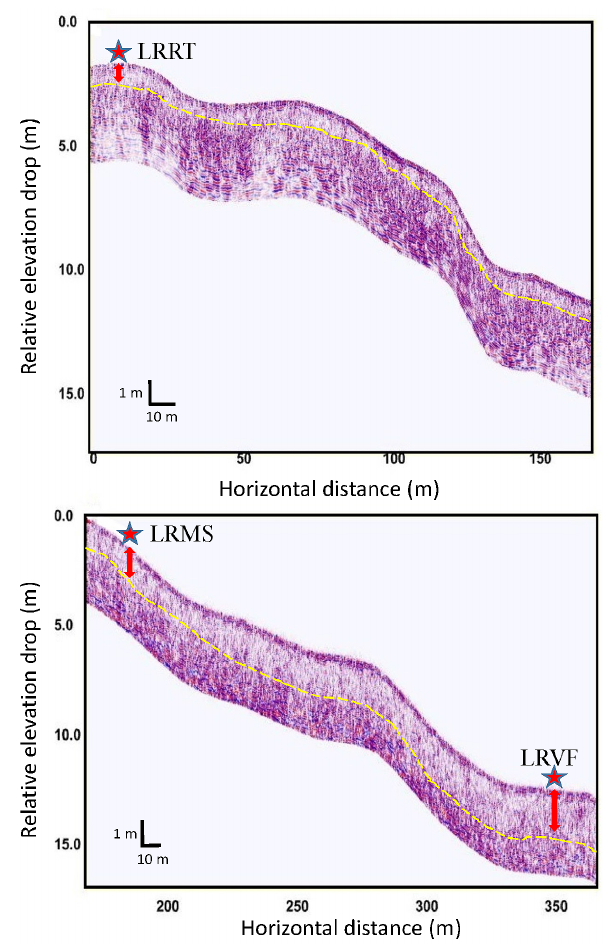
Figure 9. Ground-penetrating radar (GPR) transect of the Leading Ridge catena, showing inferred location of bedrock–soil interface (yellow dashed curve). The three soil pits (LRRT, LRMS, LRVF) are indicated by stars, with their observed depth to bedrock indi- cated by red arrow. LRRT and LRMS were dug by hand until refusal and LRVF was dug by hand and deepened with a jack hammer. GPR data are exaggerated 10 times in vertical dimension as compared to surface topography. Summary bedrock depths are tabulated in Ta- ble 4.